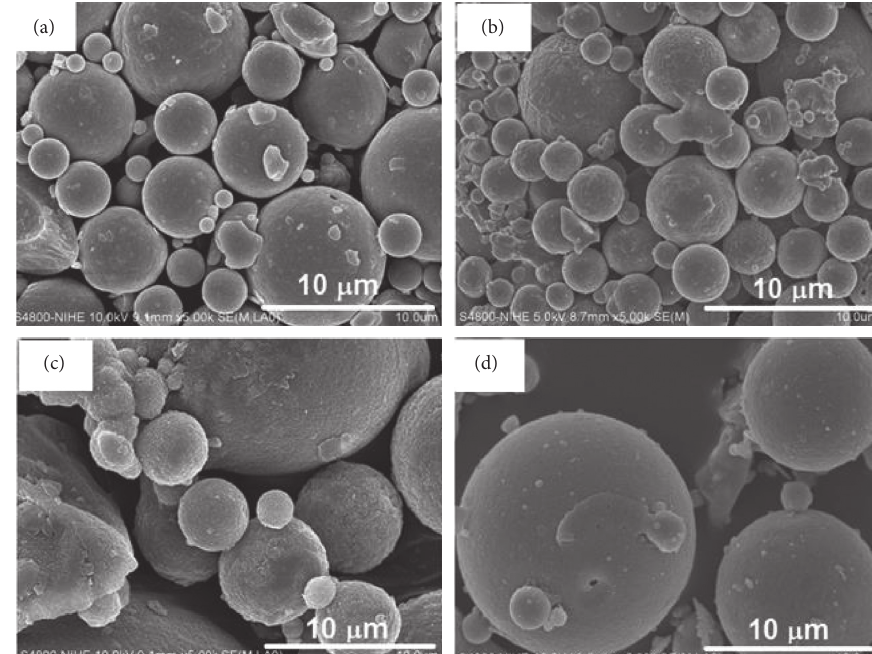
Figure 2: FESEM images of FA0 (a), FAN (b), FAMBT (c), and FASDS (d) particles at the magnification of 5.000